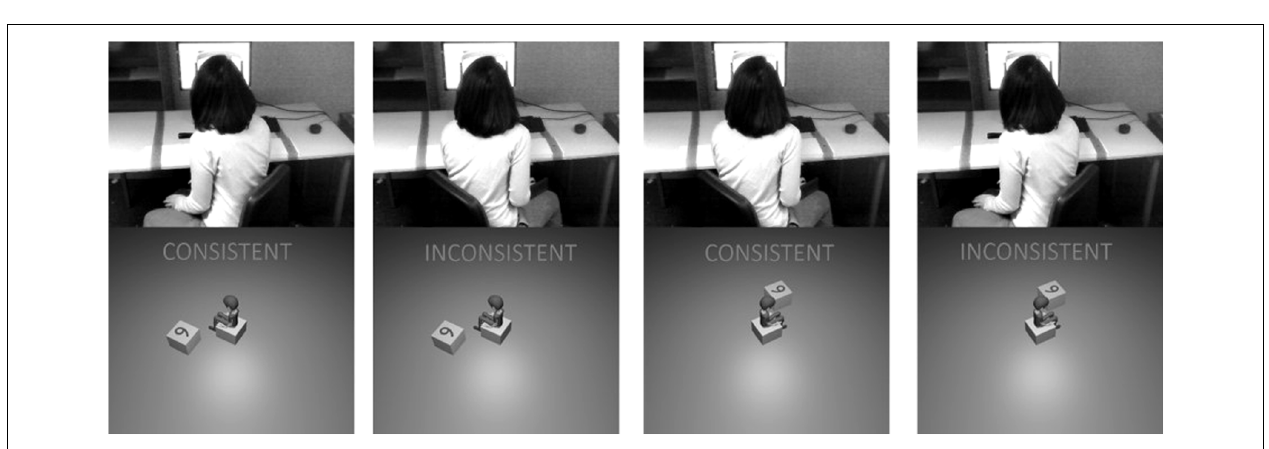
FIGURE 3 | Demonstration of Consistency effect. By turning anticlockwise, pictures showing the avatar also rotated anticlockwise are Consistent and those where the avatar has turned anticlockwise are Inconsistent. A